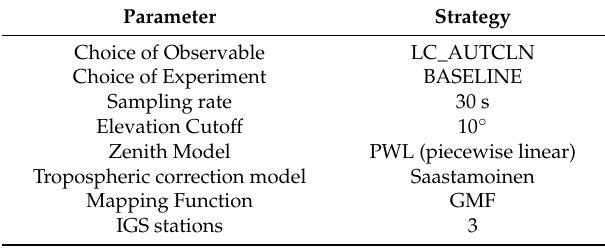
Table 2. GAMIT processing strategy for tropospheric